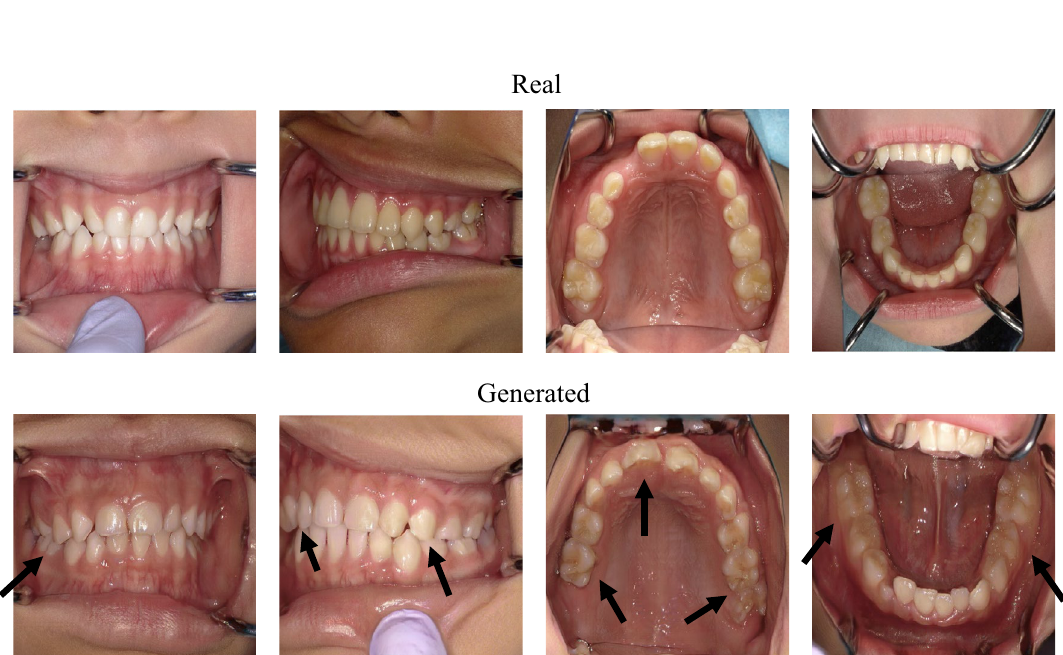
Figure 5. Comparison between real and generated intraoral images. Arrows indicate points of strange teeth. Tooth alignment and soft tissues in both images are